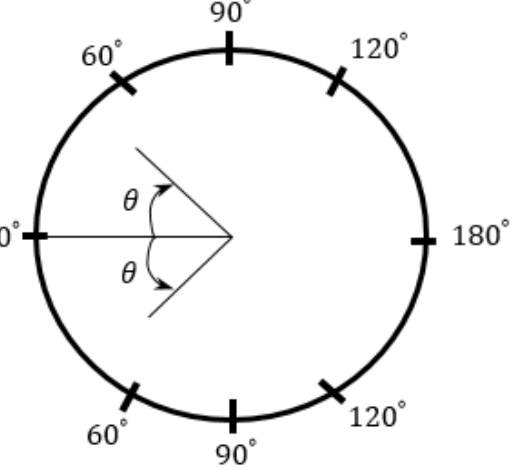
Figure 9. The division of the cylinder surface to the zines depending on the angle 𝜃 .